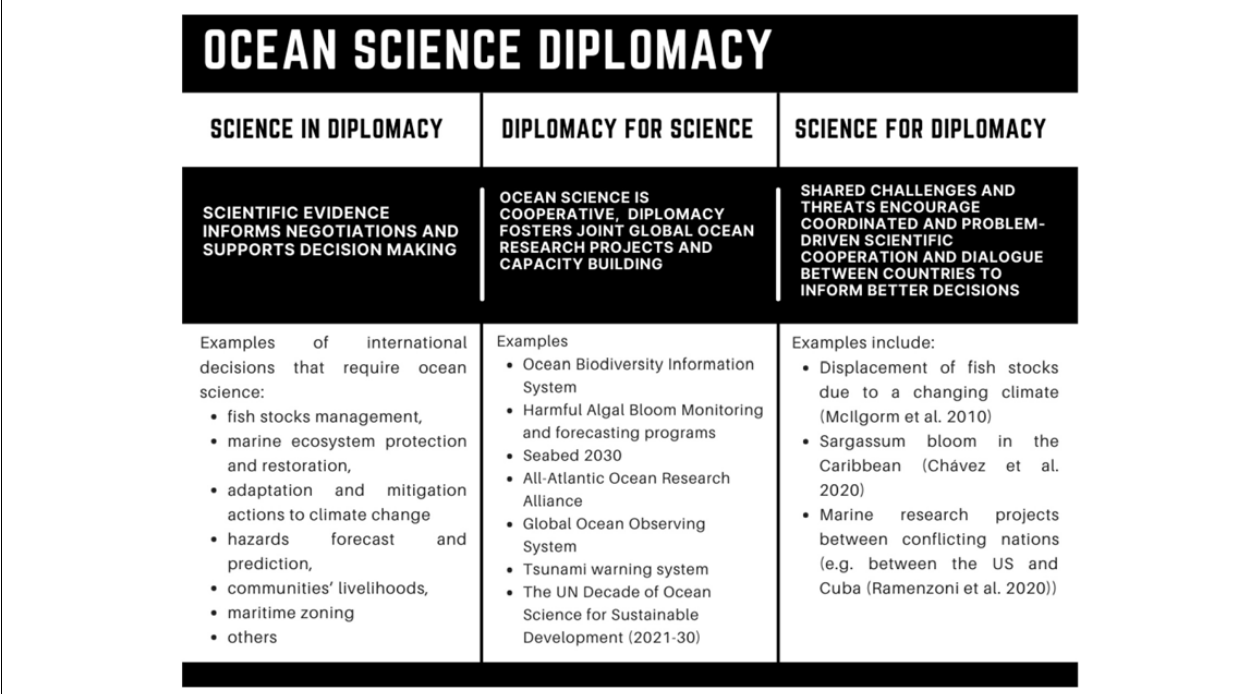
FIGURE 1 | Diagram showing the three categories of Science Diplomacy as informed by The Royal Society, and AAAS (2010), followed by examples of current matters in ocean affairs that illustrate this taxonomy.